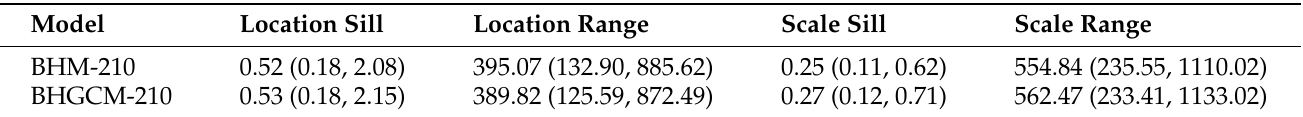
Table 3. Median (2.5%, 97.5%) of the sill and range coefficients for the location and scale parameters of models BHM-210 and BHGCM-210.